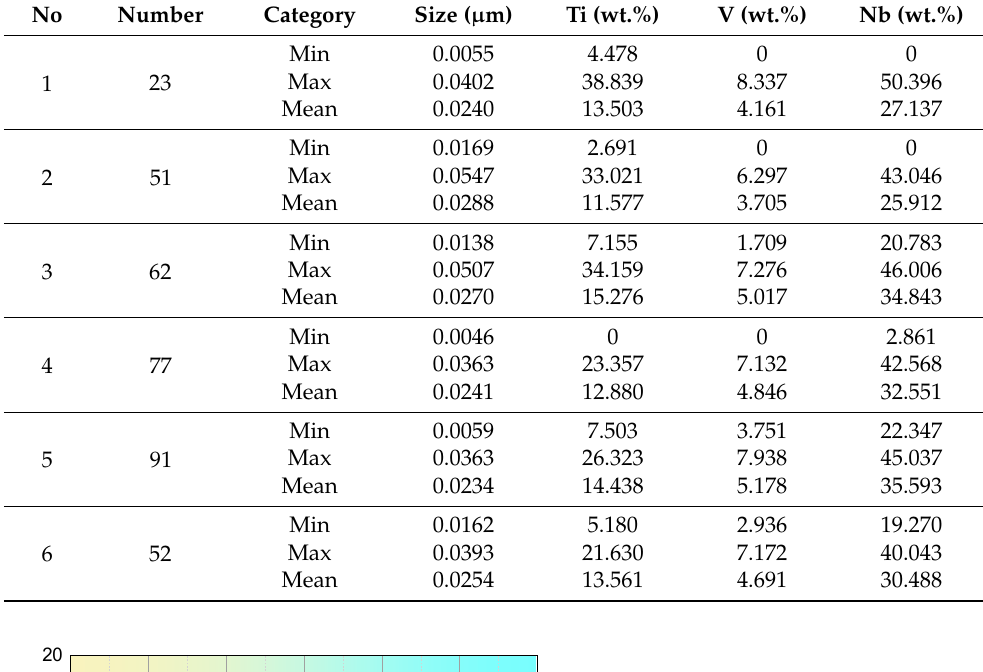
Table 5. Statistical analyses of the size and composition of precipitates in steel S2.